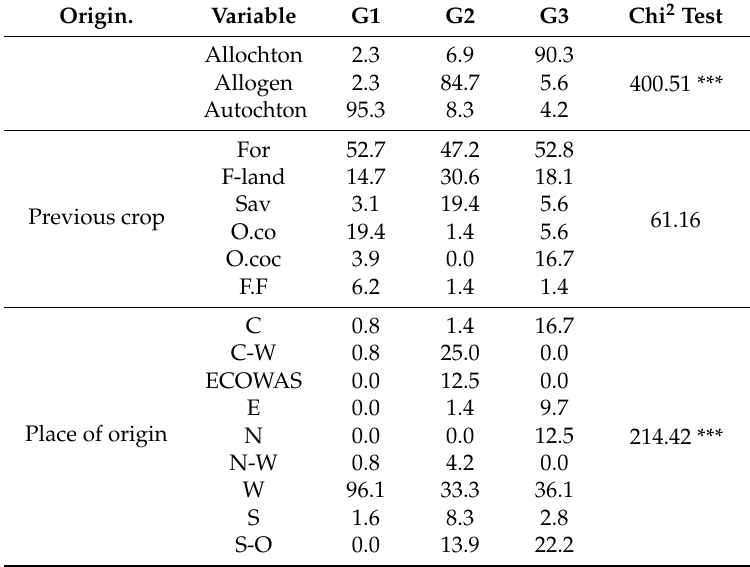
Table 6. Summary of qualitative variables characteristic of the profile of infiltrators and cocoa plantations. Origin. G1 G2